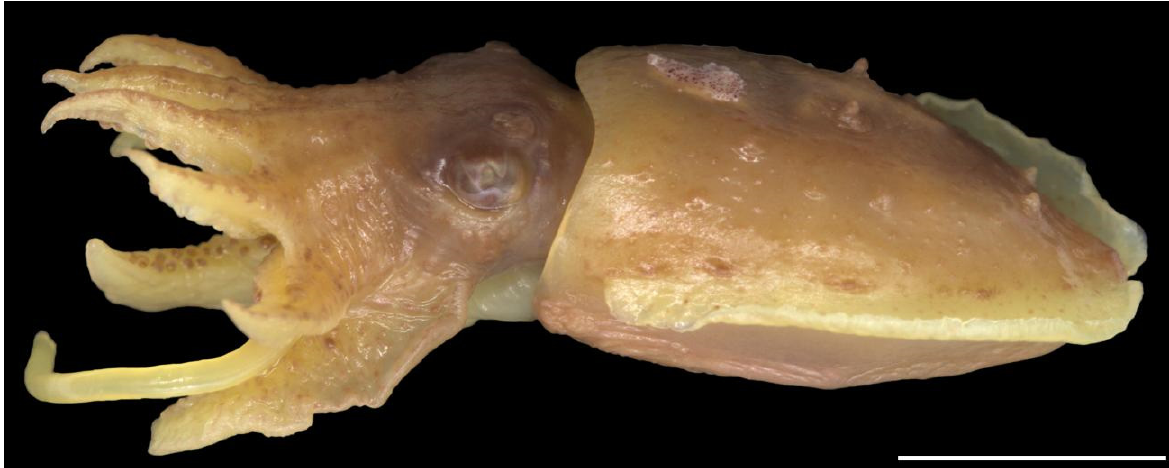
Figure 11. Lateral view of Sepia typica (SAIAB 211535 male ML 22 mm) showing the prominent structures on the dorsal mantle, supra-orbital papillae and many small tubercles on the head and arms. Scale bar 10 mm.